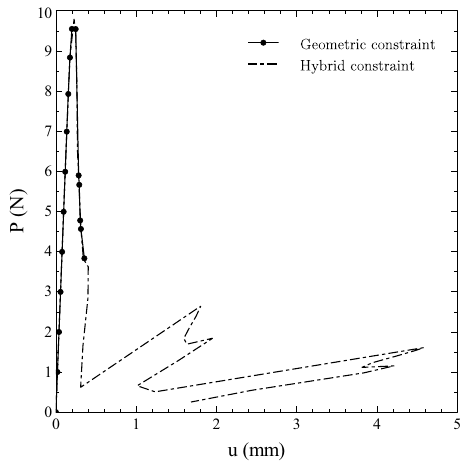
Figure 15. Force-displacement curve using different